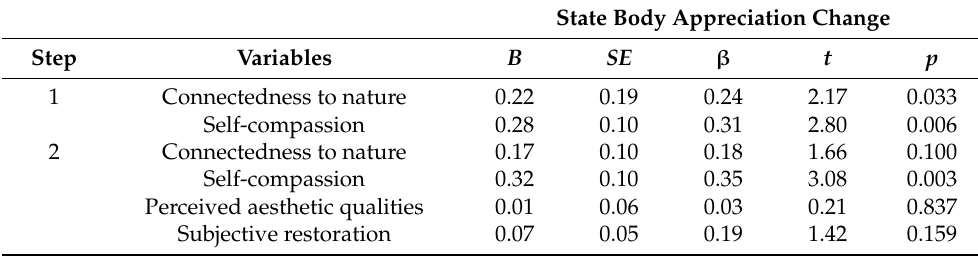
Table 2. Prediction of post-walk state body